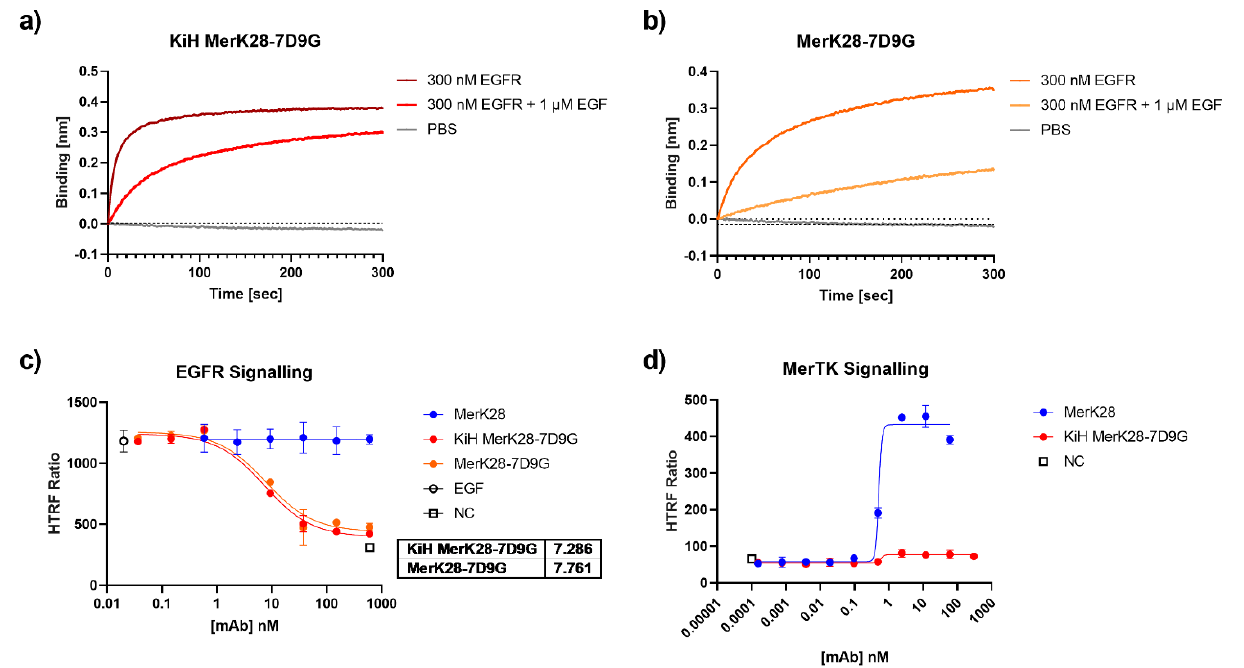
Figure 4. EGF competition and inhibition through 7D9G. EGF competition assay via BLI for ( a ) KiH MerK28-7D9G and ( b ) MerK28-7D9G. Antibodies were loaded onto AHC biosensors and either associated to 300 nM EGFR (dark red or orange), 300 nM EGF pre-incubated with 1 µM EGF (lighter red and orange), or only PBS (grey). ( c ) HTRF pAKT of A549 cells stimulated with 20 ng/mL EGF after pre-incubation with the indicated antibodies and respective concentrations. Negative control (NC) represents unstimulated cells, while EGF control shows maximum activation of pAKT. ( d ) Investigation of MerTK signalling pathway on HEK293 cells after 30 min incubation with either parental MerK28 (blue) or KiH MerK28-7D9G (red). Error bars represent the standard deviation of biological duplicates.